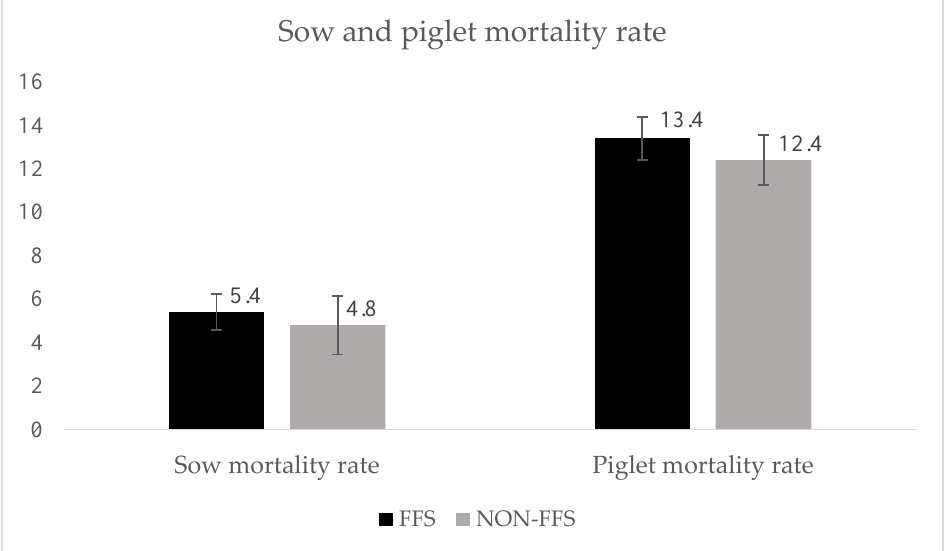
Figure 3. Sow and piglet mortality rate between FFS and non-FFS farmers.